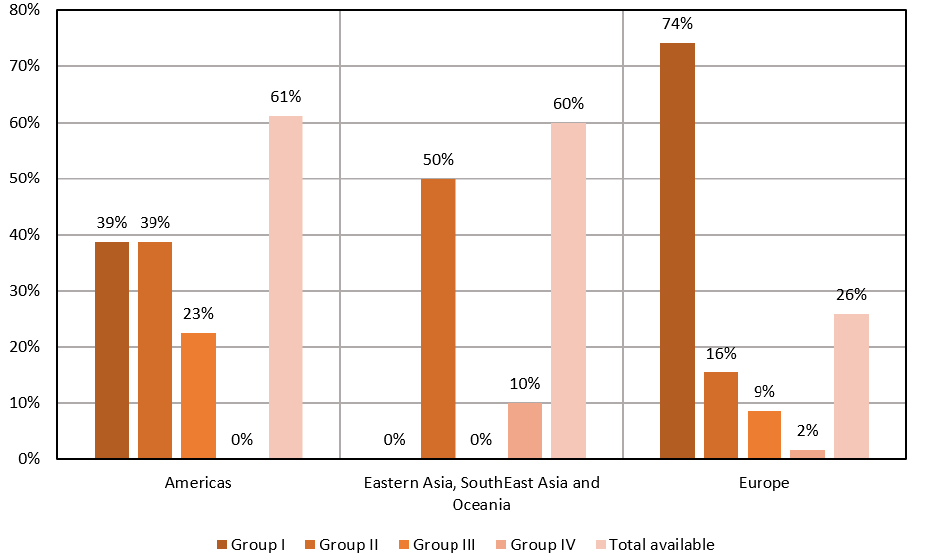
Figure 3. Bar graph for each group of SP in NMA.